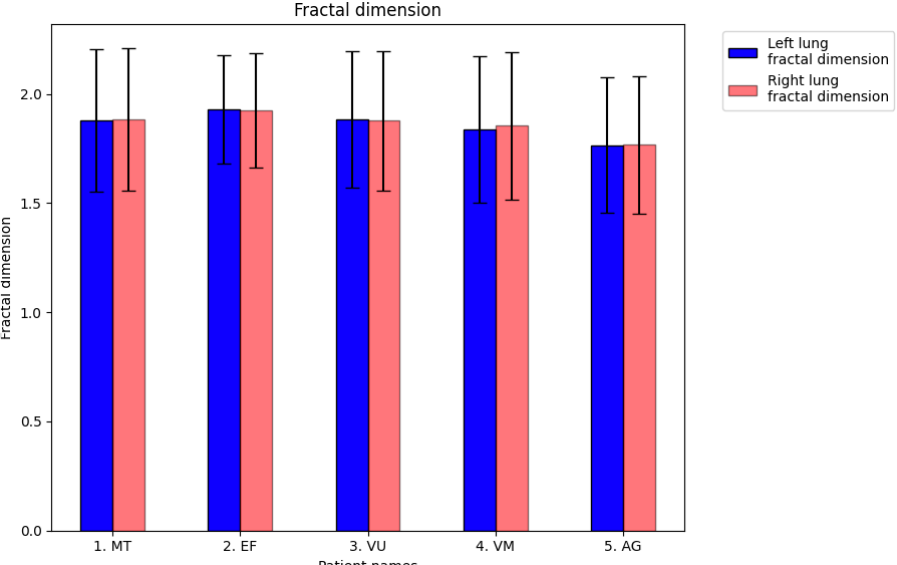
Figure 27. The fractal dimension (FD) values ( ± SEM) of CT images of the left lungs and right lungs of affected patients for a comparison with pulmonary controls.